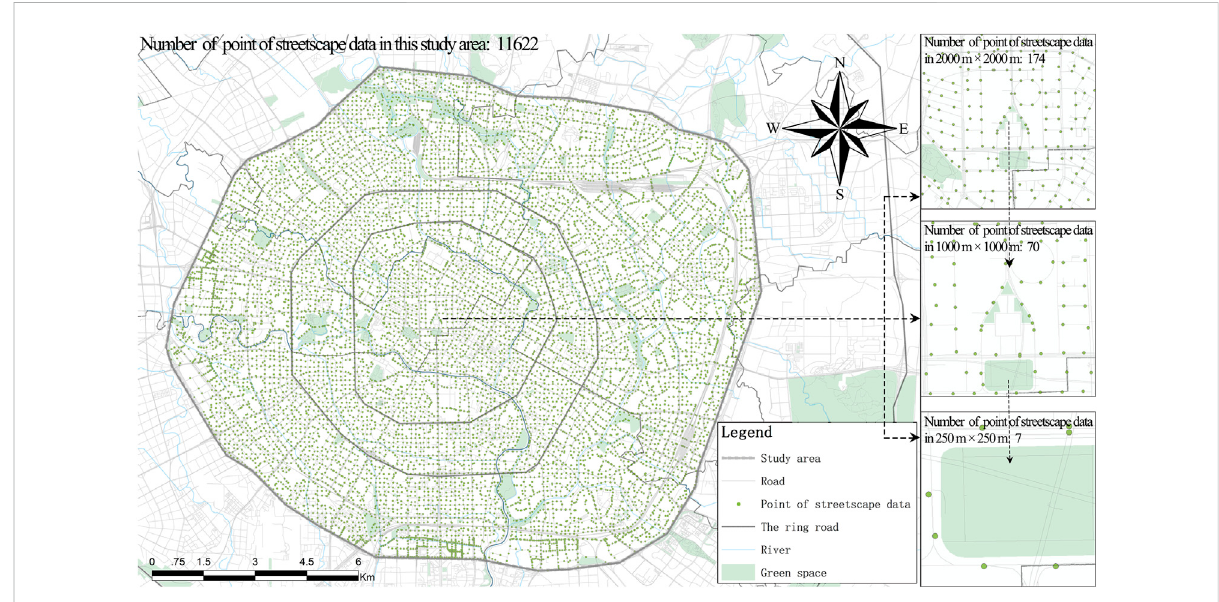
FIGURE 5 Distribution of 11622 points of street view data.